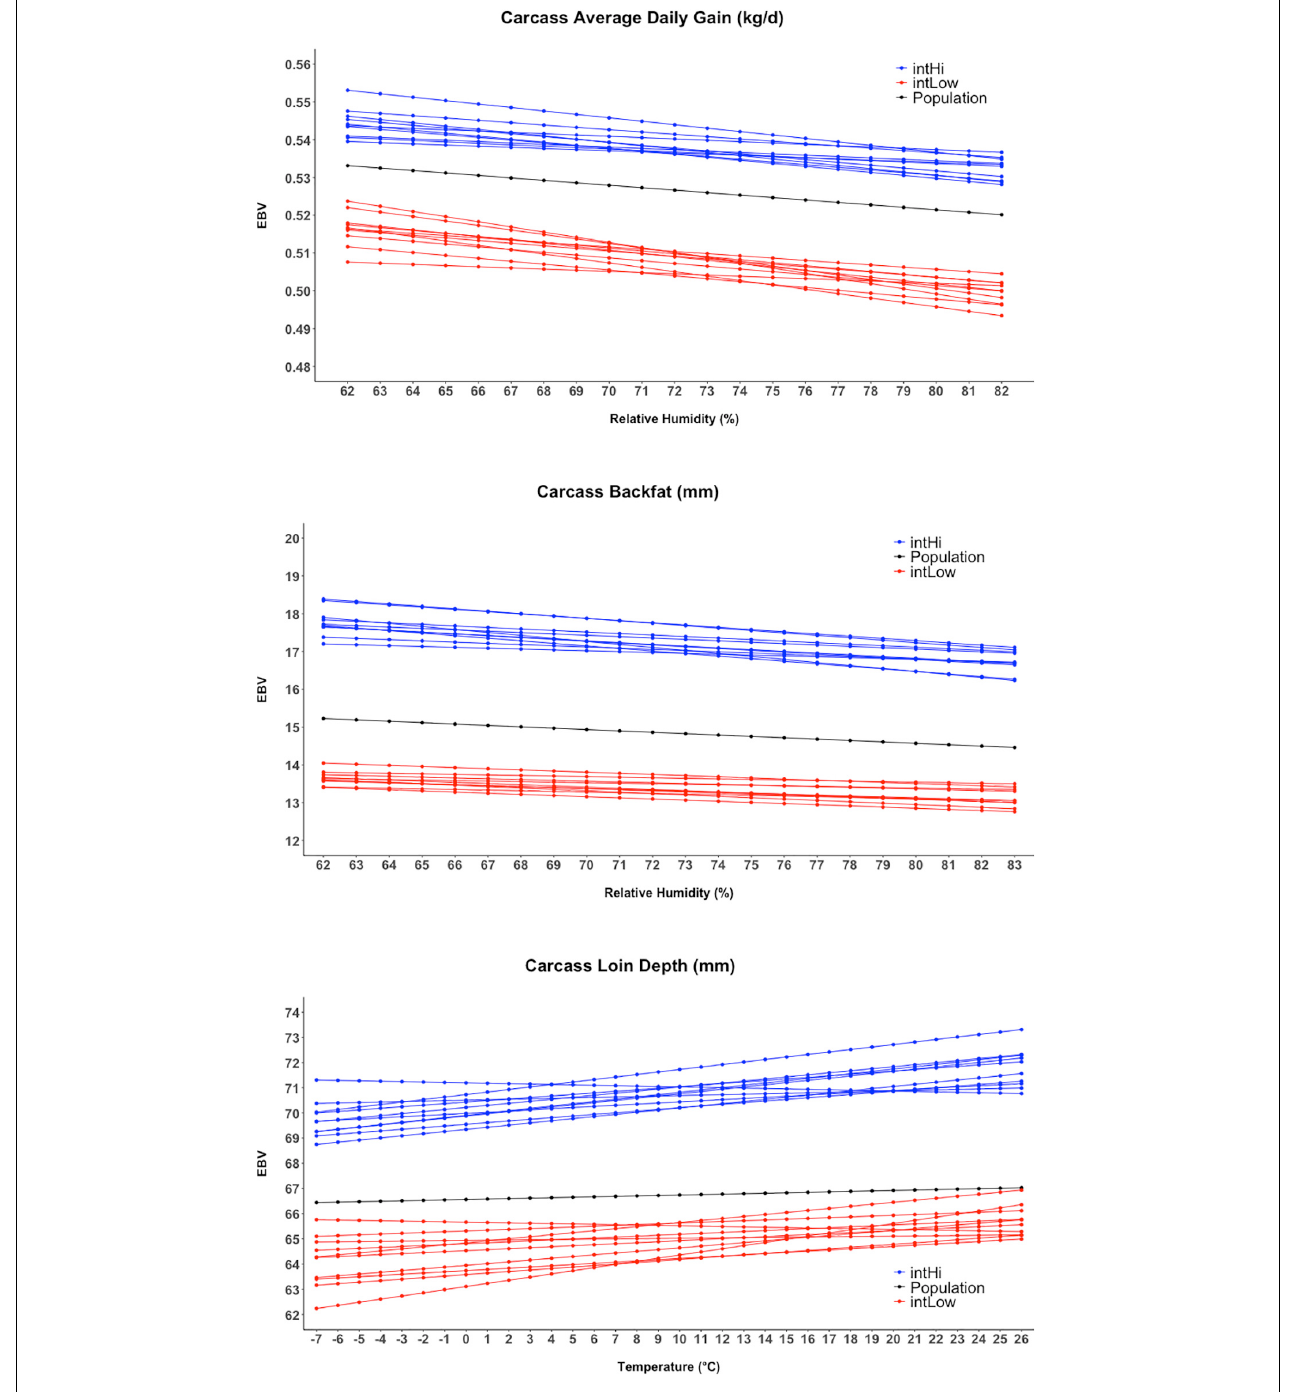
FIGURE 4 | Reaction norms for the twenty sires showing the higher and lower estimated breeding values (EBV) for the intercept term of the random regression model.